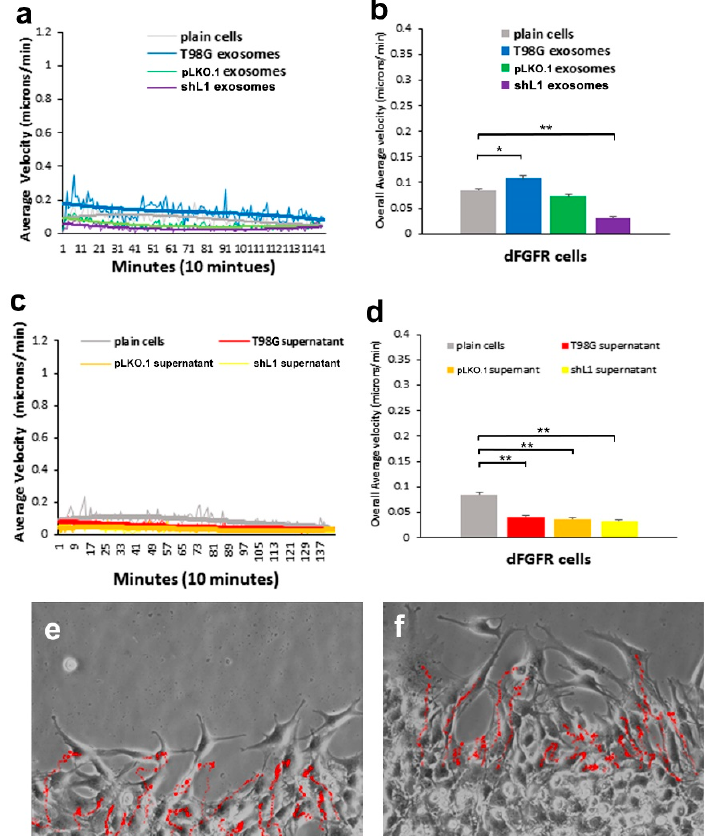
Figure 4. Motility of T98G / dFGFR cells after exosome and supernatant fraction treatment. ( a ) Average velocity of cells tracked over time with exosome fractions added. The trend line (thick line) for T98G exosome type was distinctly above those of the plain cells and shL1 exosomes. ( b ) Overall average velocity of cells with exosome treatments. ( c ) Average velocity of cells tracked over time with supernatant fractions added. ( d ) Overall average velocity of cells with supernatant treatments. Motility rates of treated cells were significantly lower than untreated. ( e , f ) Cell track images of cells with T98G exosomes and T98G supernatant fractions, respectively. * p < 0.05, ** p < 0.01.